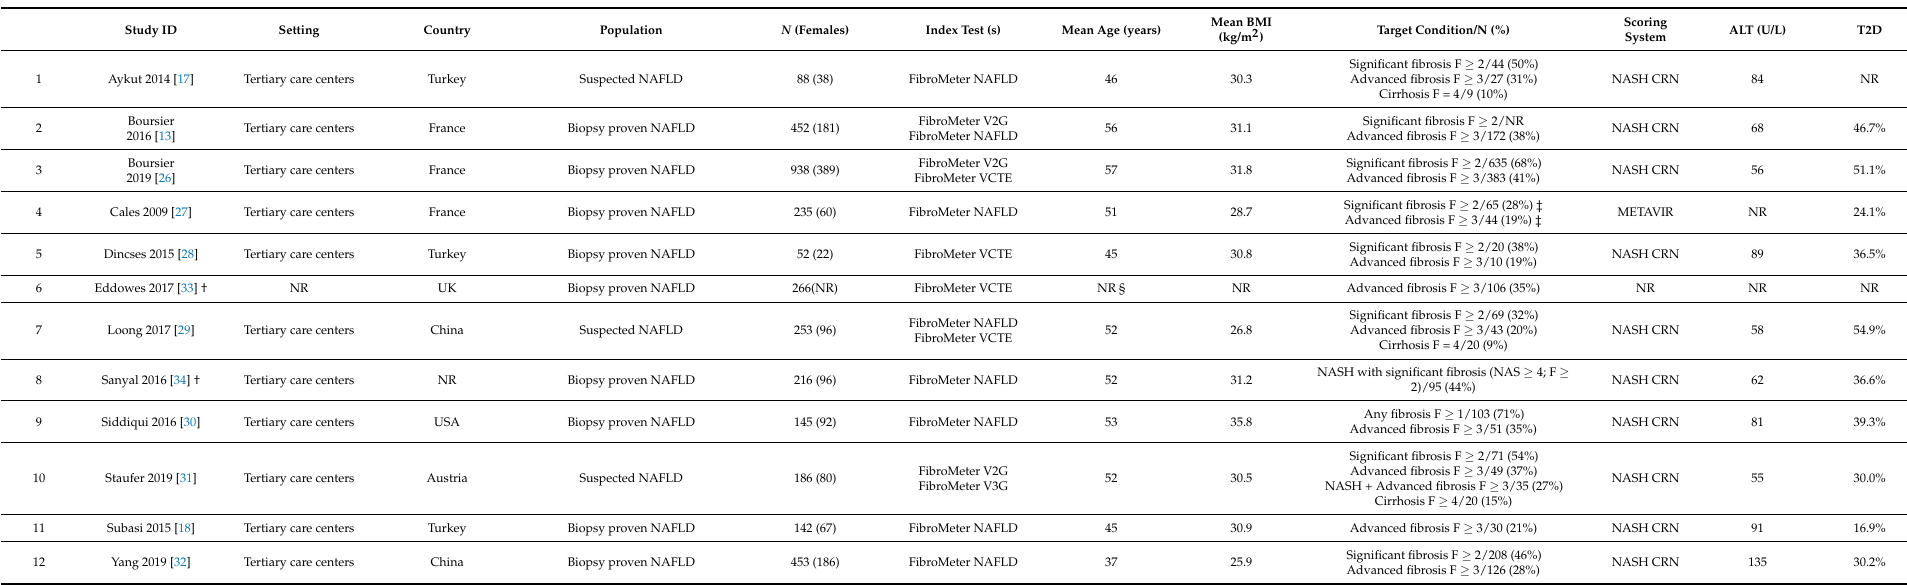
Table 1. Characteristics of included